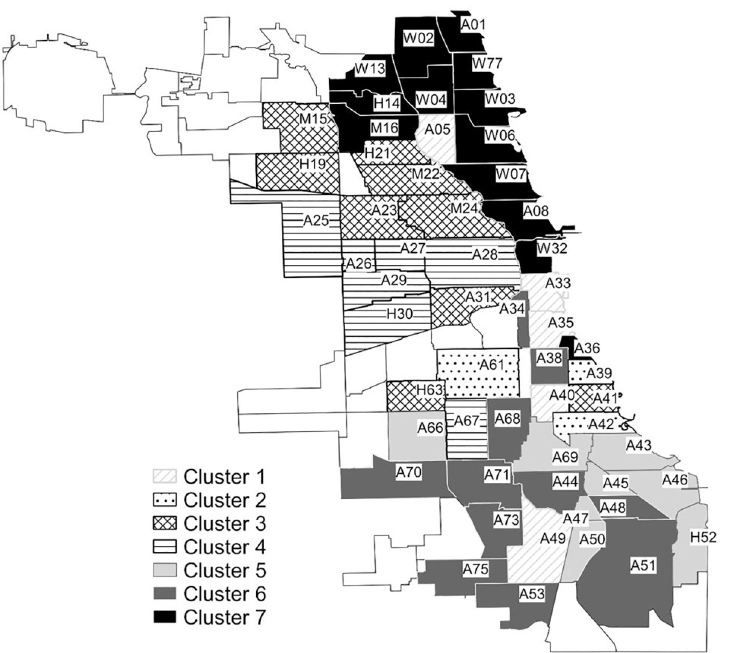
Fig 5. Seven clusters of Chicago communities based on the incidence of syphilis transmission. We color Chicago areas according to seven cluster solutions provided by our walk-betweenness approach. For each area, the first letter represents the racial/ethnic group that forms the majority in the community: A (African American), H (Hispanic), M (Mixed) (no single racial/ethnic group forms the majority), and W (white) and the next two-digit number represents the community number in the Chicago area. The map is from the Chicago Data Portal (https://data.cityofchicago.org/ Facilities-Geographic-Boundaries/Boundaries-Community-Areas-current-/cauq-8yn6). This site provides applications using data that has been modified for use from its original source, www.cityofchicago.org, the official website of the City of Chicago. The City of Chicago makes no claims as to the content, accuracy, timeliness, or completeness of any of the data provided at this site. The data provided at this site is subject to change at any time. It is understood that the data provided at this site is being used at one’s own risk.